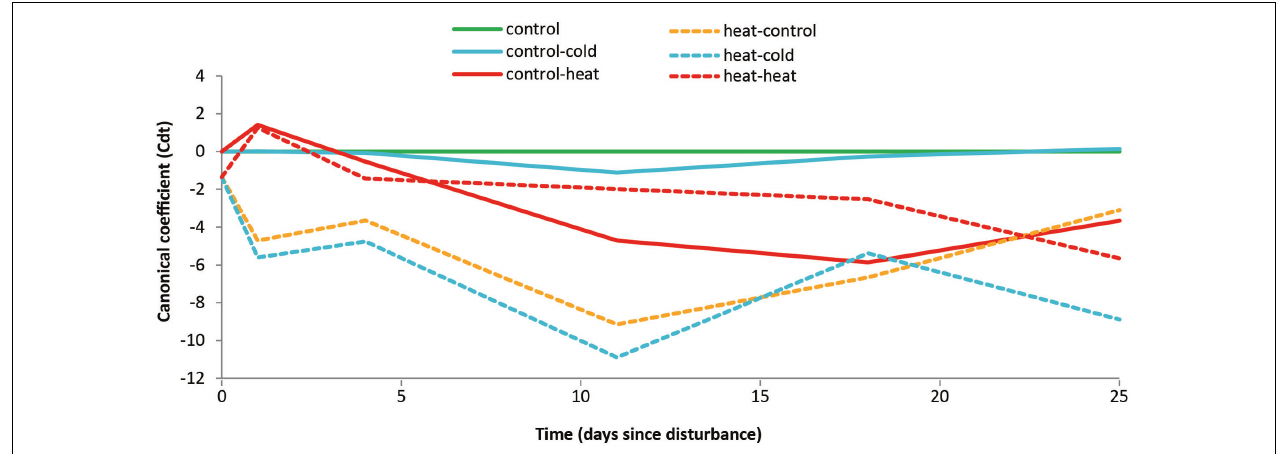
FIGURE 4 | Effects of a prior heat shock on the recovery of the bacterial community composition. Principal response curve of OTU abundances over time. Line color represents different disturbance types (blue, red, and orange) or the undisturbed control soil (green). Canonical coefficients indicate the distance between the community composition of samples from all treatments relative to the undisturbed control. Previously undisturbed treatments are shown as solid lines, and previously disturbed treatments are shown as dashed lines. The variance explained by Time is 18.6%; the variance explained by Time ∗ Treatment is